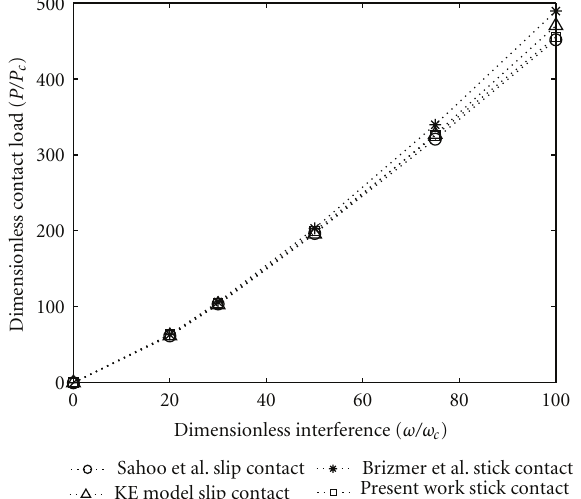
Figure 4: Dimensionless contact load versus dimensionless inter- ference for various models.